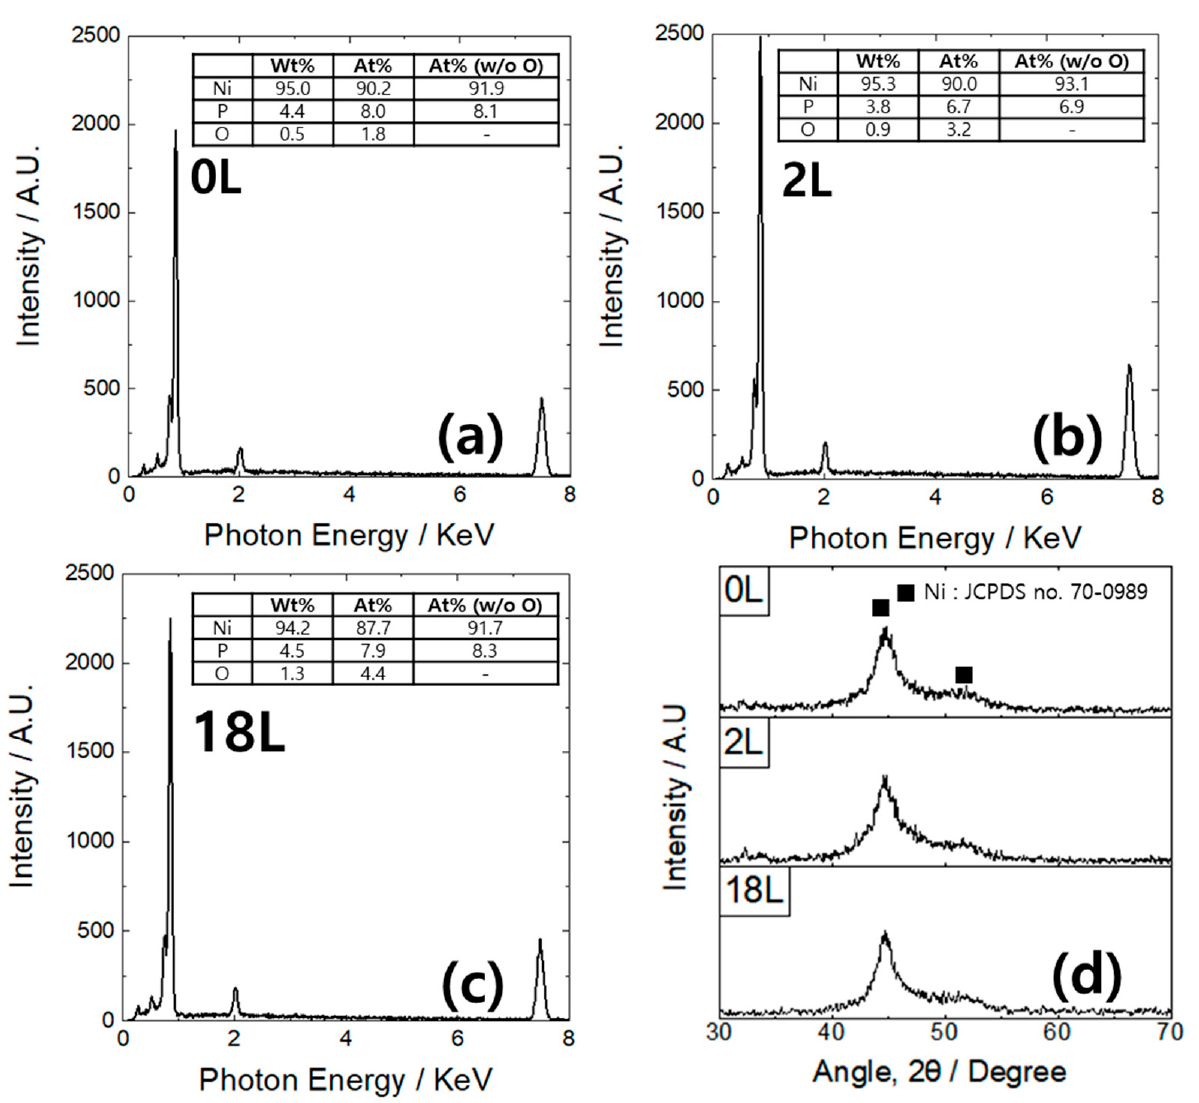
Figure 2. EDS spectra together with chemical composition ratios of the nickel phosphide nanowires prepared at different values of magnetic field strength: ( a ) sample 0L, ( b ) sample 2L, and ( c ) sample 18L from Table 1; and ( d ) their XRD patterns.